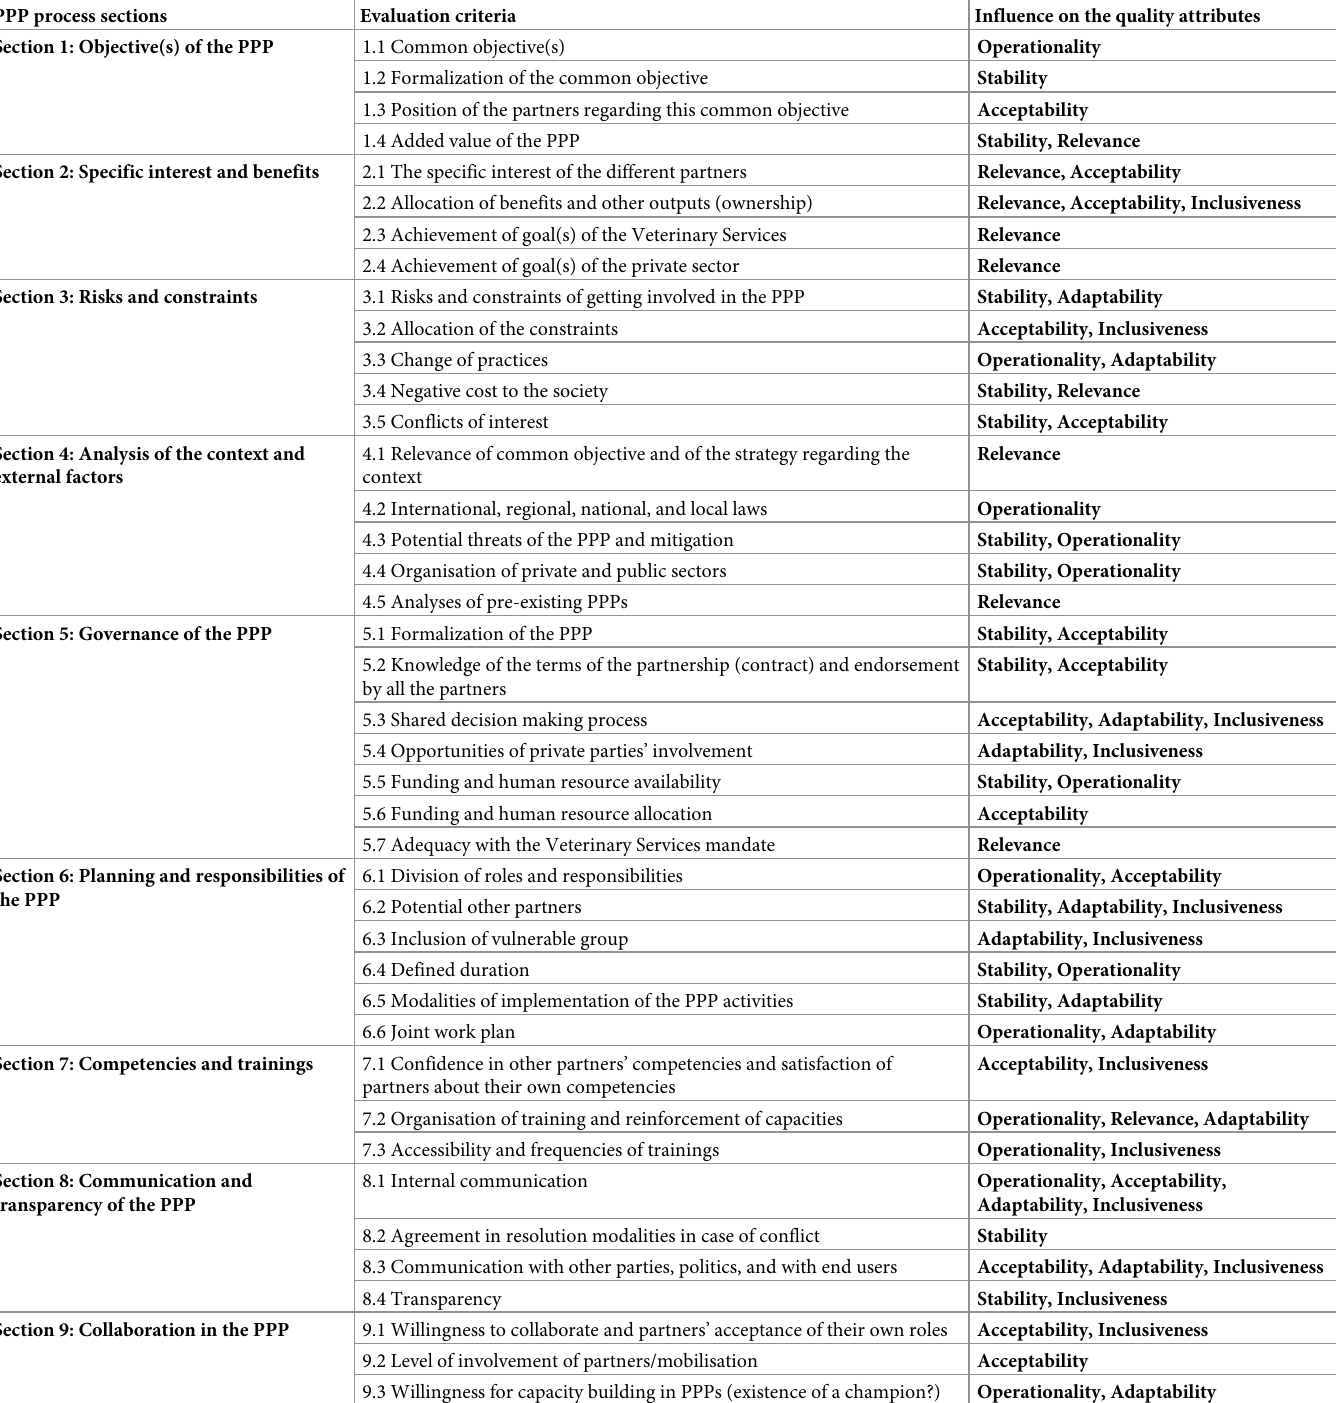
Table 2. Presentation of the tool validated by the experts’ elicitation: 10 sections of the public-private partnership process, 44 evaluation criteria, and 6 quality attri- butes. The sections represent the public-private partnership process organization and activities. Each sections is composed of a set of evaluation criteria. The six quality attributes assess the influence of the public-private partnership process on its performance. The evaluation criteria and the quality attributes were validated if 85% or more of the experts considered them to be